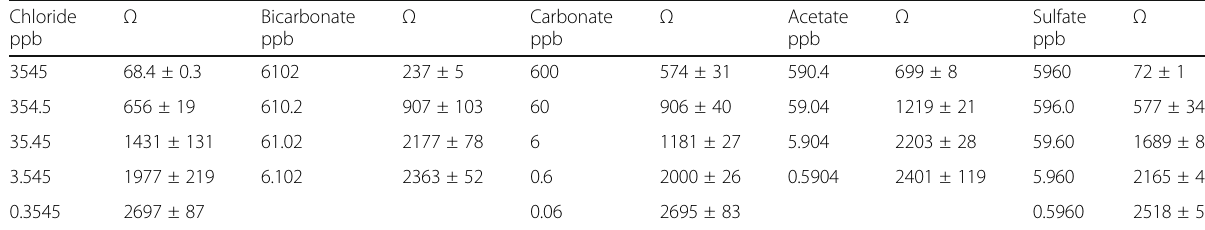
Table 2 The ppb amounts of prepared standard anion solutions, real resistance determined by fitting the Nyquist plot and error measured at 25.0